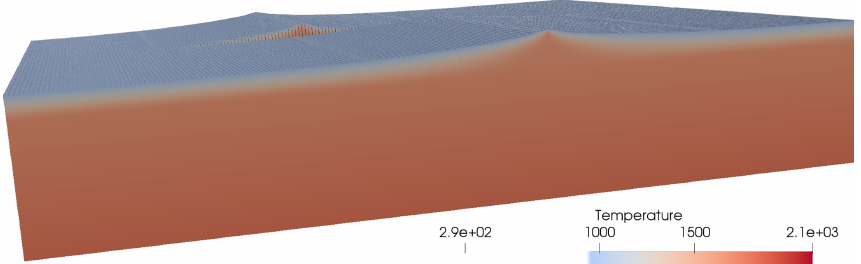
Figure 3. The temperature field of the 3-D two-rift system example. Material with a temperature below 950K has been omitted in order to better show the rifts. Note the second rift system in the background.